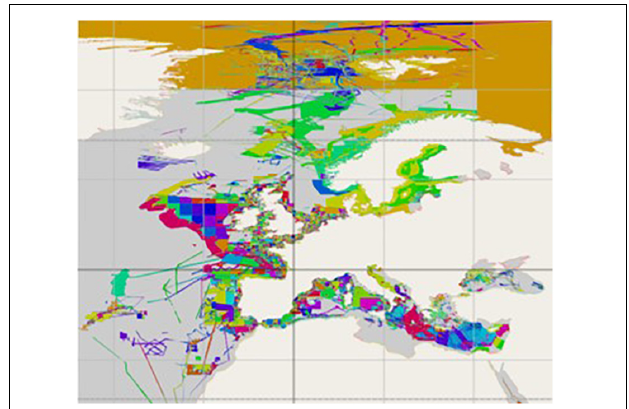
FIGURE 4 | EMODnet different datasets from different providers (26,447 datasets and 181 Composite DTMs).